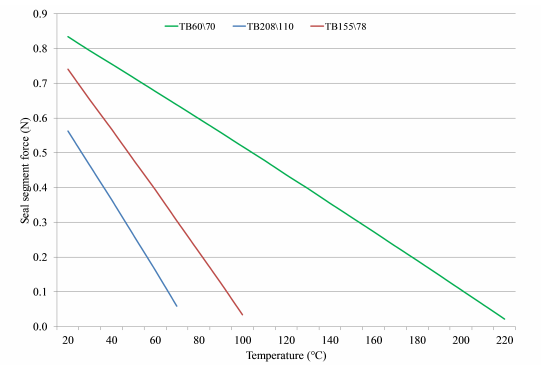
Figure 10: Seal segment force as a function of temperature for vari- ous bimetal